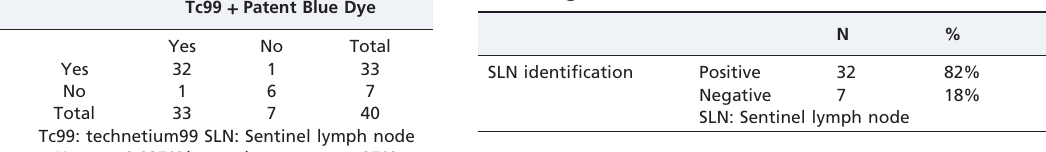
Table 3 - Identification of the SLN in the bitch axilla using blue dye injection into the dermal region of the upper edge of the arcuate incision in the left superior quadrant of the right and left breasts.